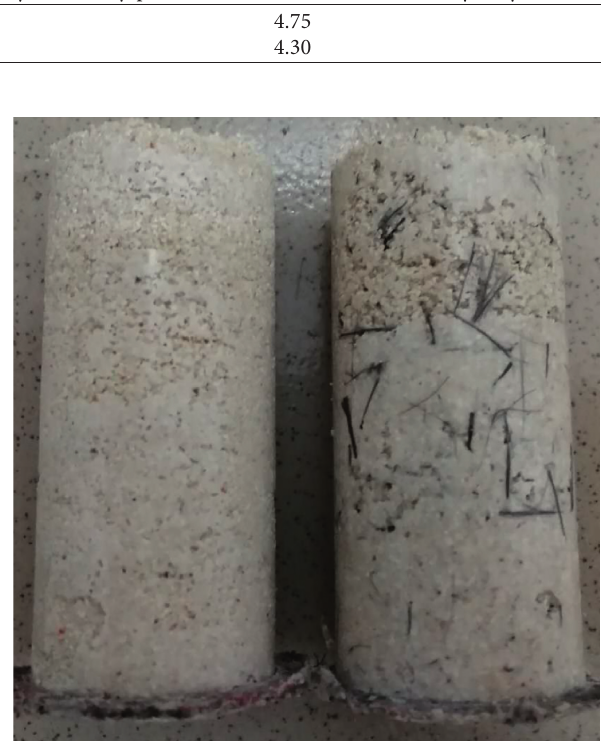
Figure 5: Microbial solidified sample of calcareous sand in private